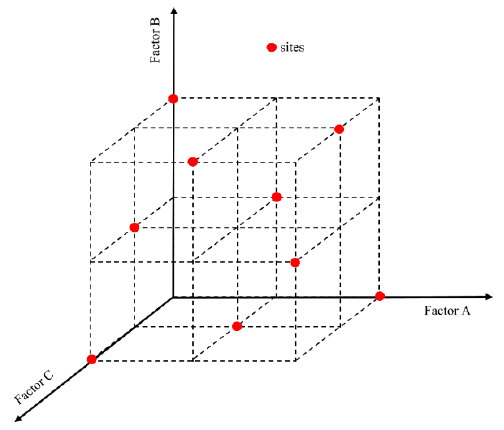
Table 4. Research interval of microparameters. Figure 4. Distribution of test points in orthogonal experiments. Figure 4. Distribution of test points in orthogonal Table 5. Horizontal table of design factors of orthogonal experiment.